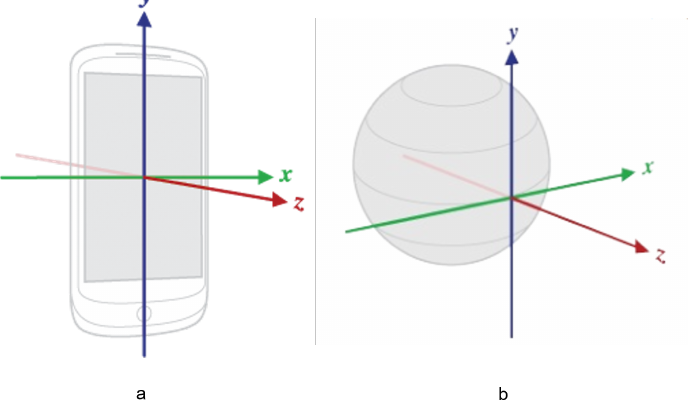
Figure 5. ( a ) Coordinate system (relative to a device) used by the Sensor API. ; ( b ) Earth’s coordinate system, a 3-axis